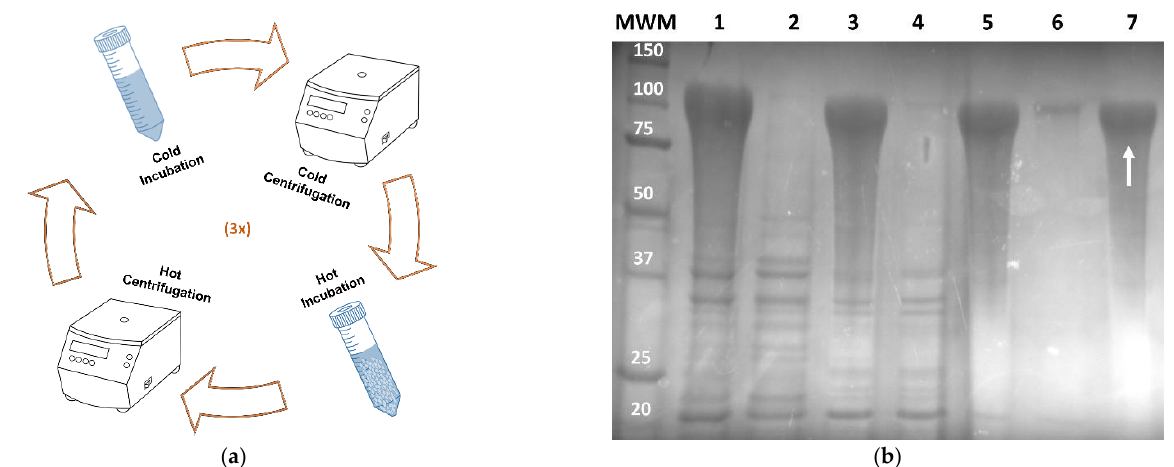
Figure 1. Purification of AMP-A200-based protein polymers. ( a ) Schematic representation of the purification process by ITC. ( b ) Representative SDS-PAGE analysis of purification for Syn-A200. After sonication and acidification to pH 3.5, the insoluble debris was removed by centrifugation and the recombinant protein polymer was purified from the clear supernatant (lane 1) by ITC using hot/cold cycles. For each cycle, the protein-enriched solution was heated to 37 ◦ C and then centrifuged at the same temperature. The resulting hot supernatant was discarded (lanes 2, 4 and 6) and the precipitated protein was resuspended in ice-cold ddH 2 O. After complete resuspension, the solution was centrifuged at 4 ◦ C, and the resulting cold supernatant (lanes 3, 5 and 7) was submitted to a new cycle. A pure protein polymer fraction (indicated by the white arrow) was obtained after three complete cycles. MWM—molecular weight marker (Precision Plus Protein Unstained Standards from Bio-Rad) in kDa; 1—cycle one, cold supernatant; 2—cycle one, hot supernatant; 3—cycle two, cold supernatant; 4—cycle two, hot supernatant; 5—cycle three, cold supernatant; 6—cycle three, hot supernatant. Gel was stained with 0.3 M CuCl 2 .